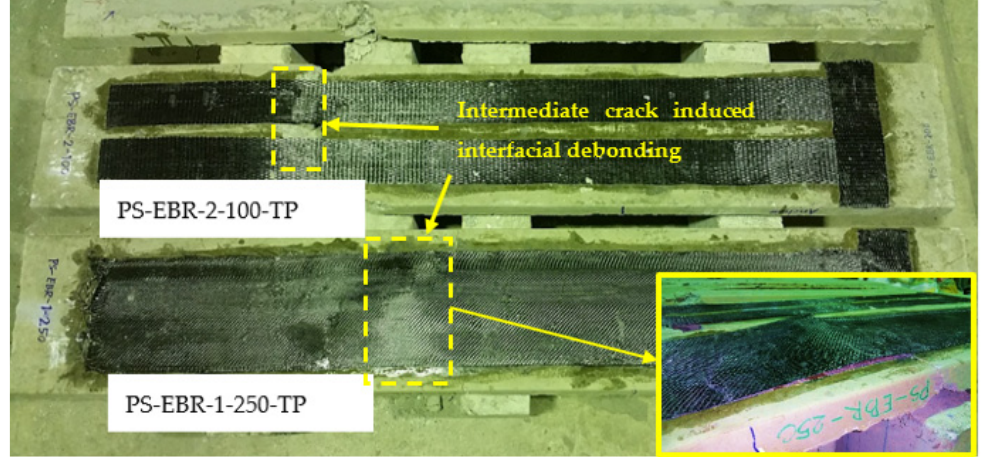
Figure 4. Application of EBR CFRP sheets at the slab’s soffit (PS-EBR-2-100).